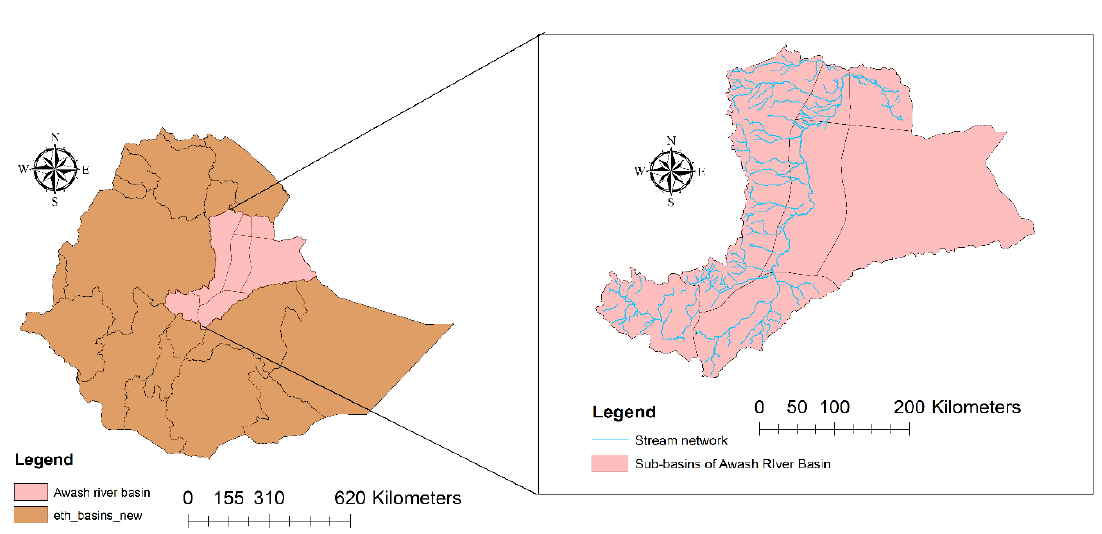
Figure 1. Major River Basins in Ethiopia and, more specifically, the Awash River Basin.